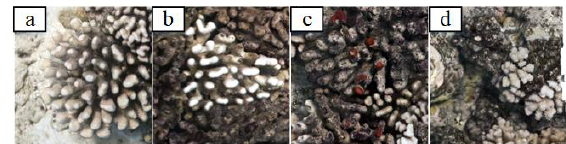
Figure 5 . Different states of corals. (a) living, (b) dead with completely bleached, (c) dead with wormholes and rust spots, (d) dead covered in algae.